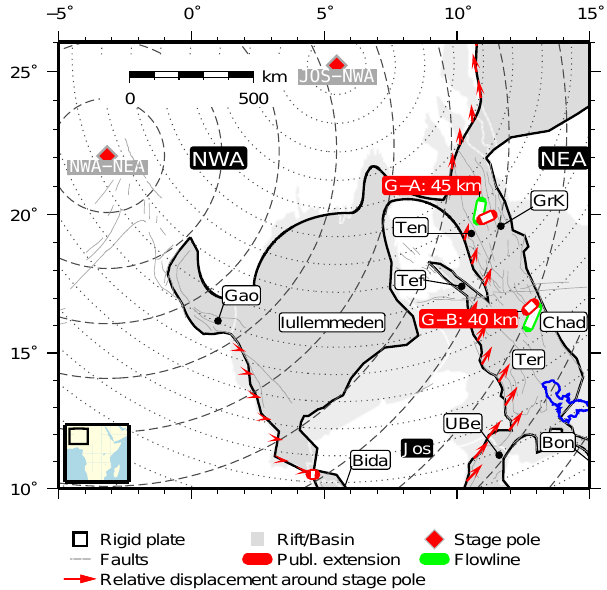
Fig. 7. Stage pole rotation and associated small circles (dashed and stippled grey lines) at 2 ◦ spacing for 145–110Ma interval for the West African Rift system (WARS) and associated relative plate motions at 110ma. Main plates: NEA – northeast Africa; NWA – nortwest Africa; Jos – Jos Sub-plate. Main rifts: Gao – Gao Trough; UBe – upper Benue; Ter – Termit; Bgr – Bongor; Tef – Tefidet; Ten – T´en´er´e; GrK – Grein–Kafra. Basins: Chad – Chad Basin; Iullemmeden – Iullemmeden Basin; Bida – Bida Basin. Red boxes and text indicate published profiles for Grein–Kafra and Ter- mit rifts and estimated extension values based on Genik (1992): G-A – profile A-A’; G-B – profile B-B’. Vectors shown on map only show relative motions, white core of published profiles and of green flowlines indicates actual amount of extension in km. These are ≈ 45km for profile G-A and 40–80km for profile G-B, (red; Genik, 1992), with modelled extension of ≈ 28km and ≈ 43km (green), respectively. Red vectors indicate angular displacement of rigid block around stage poles back to fit reconstruction position. Vectors northeast of the Grein–Kafra rift indicate possible Early Cretaceous basin-and-swell topography related to strike-slip reac- tivation of basement structures in southern Lybia based on Guiraud et al.